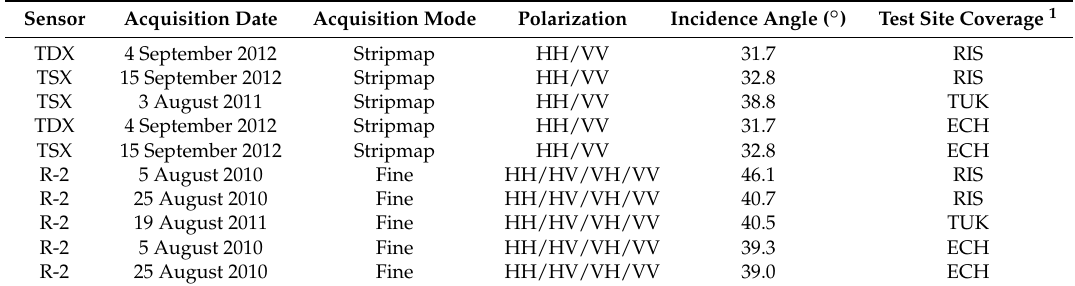
Table 1. Acquisition parameters of TerraSAR-X (TSX), TanDEM-X (TDX) and Radarsat-2 (R-2).